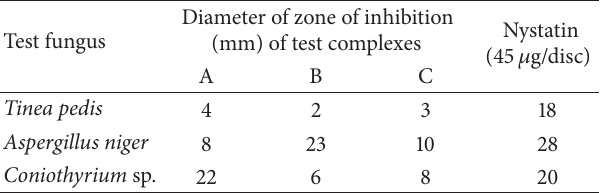
Table 13: Zone of inhibition of antifungal activity of test complexes.